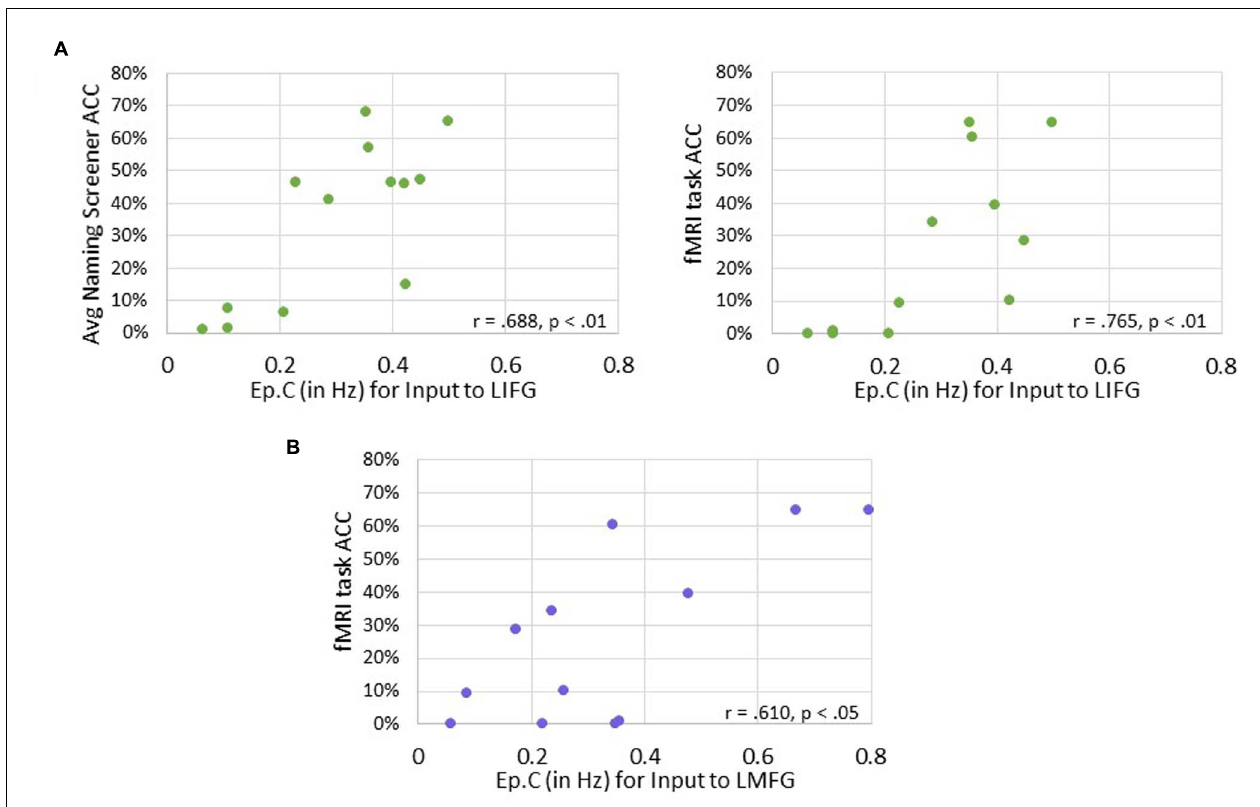
FIGURE 10 | Correlations between behavioral accuracy and strength of task-induced perturbation to specific regions (i.e., Ep.C values in Hz). (A) For family #1, significant associations were found between strength of task-induced perturbation to LIFG and accuracy on the naming screener (shown on the left) and on the fMRI task (shown on the right). (B) For family #2, a significant relationship was seen between strength of driving input to LMFG and fMRI task